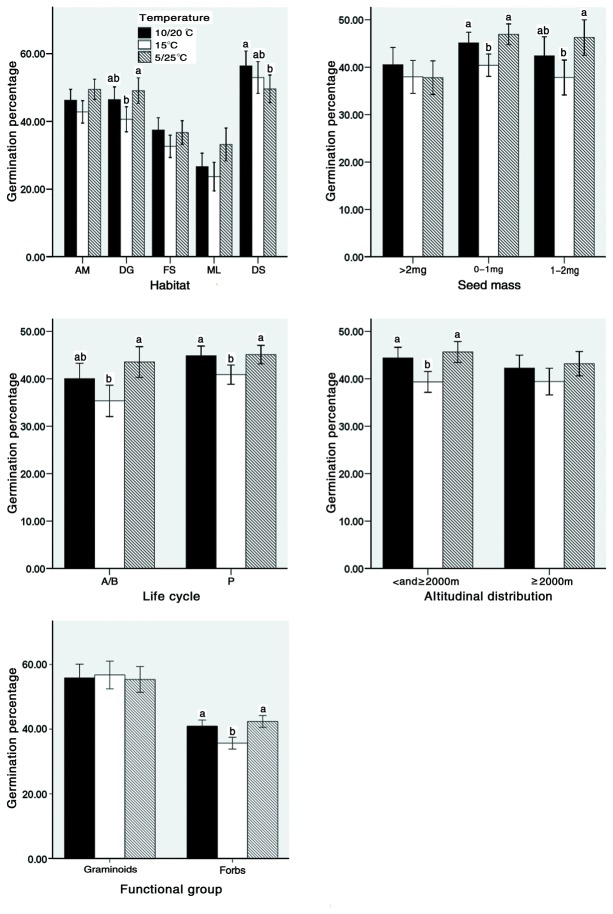
Germination percentages at different temperature regimes of species that differ in habitat, seed mass, life cycle type, altitudinal distribution and functional group.AM: alpine/ subalpine meadow; DG: disturbed ground; FS: forest margin/scrub; ML: marshland; DS: dry sunny slope; A/B: annuals/biennials; P: perennials; Error bars: ±SE. For each group of species, different letters on the bars indicate significant differences in germination under different temperature conditions at P < 0.05 (multiple comparisons with the Friedman Test).